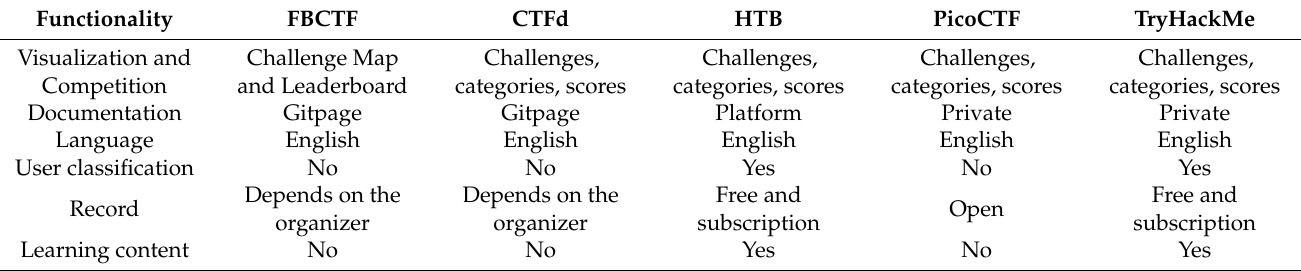
Table 1. Functional criteria measurement